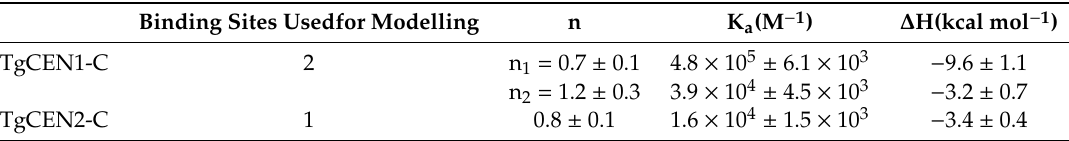
Figure 6. Ca 2 + binding to TgCEN1-C and TgCEN2-C. ( A , B ) Representative Ca 2 + titration of apo-TgCEN1-C ( A ) and apo-TgCEN2-C ( B ) as monitored by ITC. Representative raw heat-power changes (upper panels) and integrated binding isotherms (bottom panels). A first injection of 0.5 µ L was made and then the first data point was removed from data fitting. Curve fitting was performed by considering the two binding sites model for TgCEN1-C and the one site model for TgCEN2-C. The protein concentration was 70 µ M and 100 µ M, for apo-TgCEN1-C and apo-TgCEN2-C, respectively. ( C ) The downfield region of the 1 H- 15 N HSQC NMR spectra of TgCEN1-C recorded as a function of increasing Ca 2 + concentration. The molar ratio of Ca 2 + :protein in each case was 0.9, 1.5, 4, and 10 (from left to right). Table 1. Thermodynamic parameters for Ca 2 + binding to TgCEN1-C and TgCEN2-C. The mean values ± SEM from triplicate experiments using at least two di ff erent protein preparations are presented. Binding Sites Usedfor Modelling